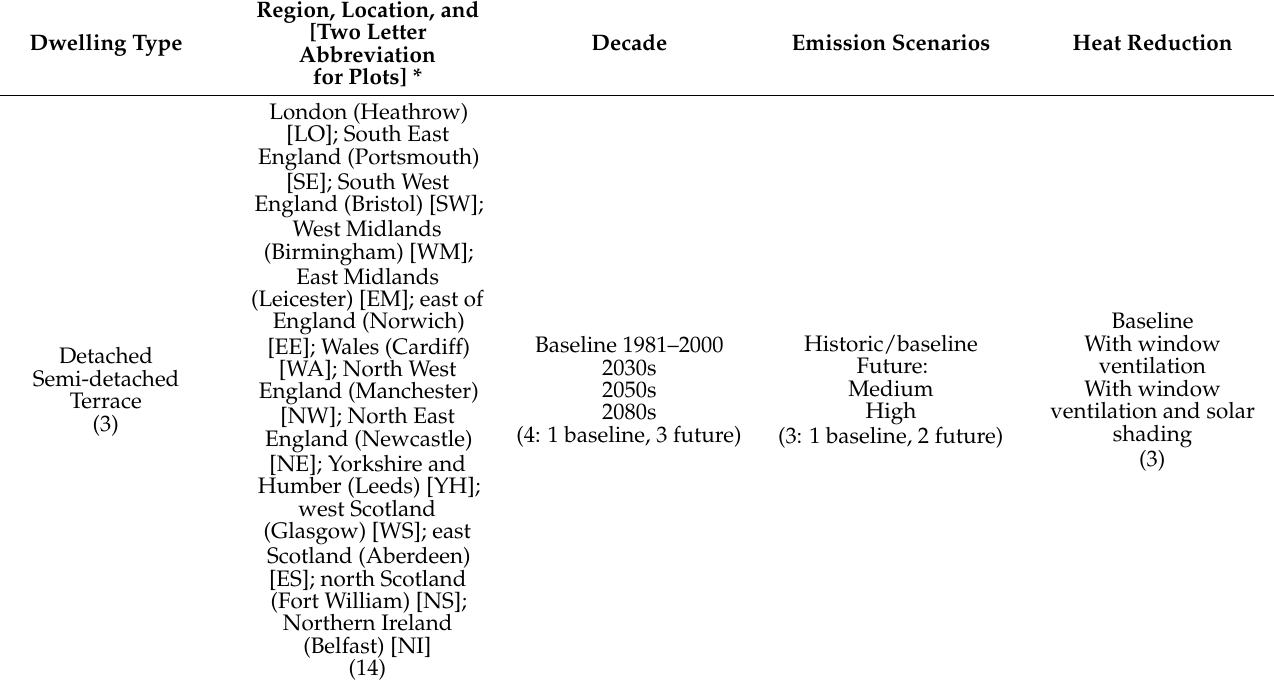
Table 8. Permutations of dwelling, regions (location), decade, and emission scenario used in simulations. Region, Location, and [Two Dwelling Type